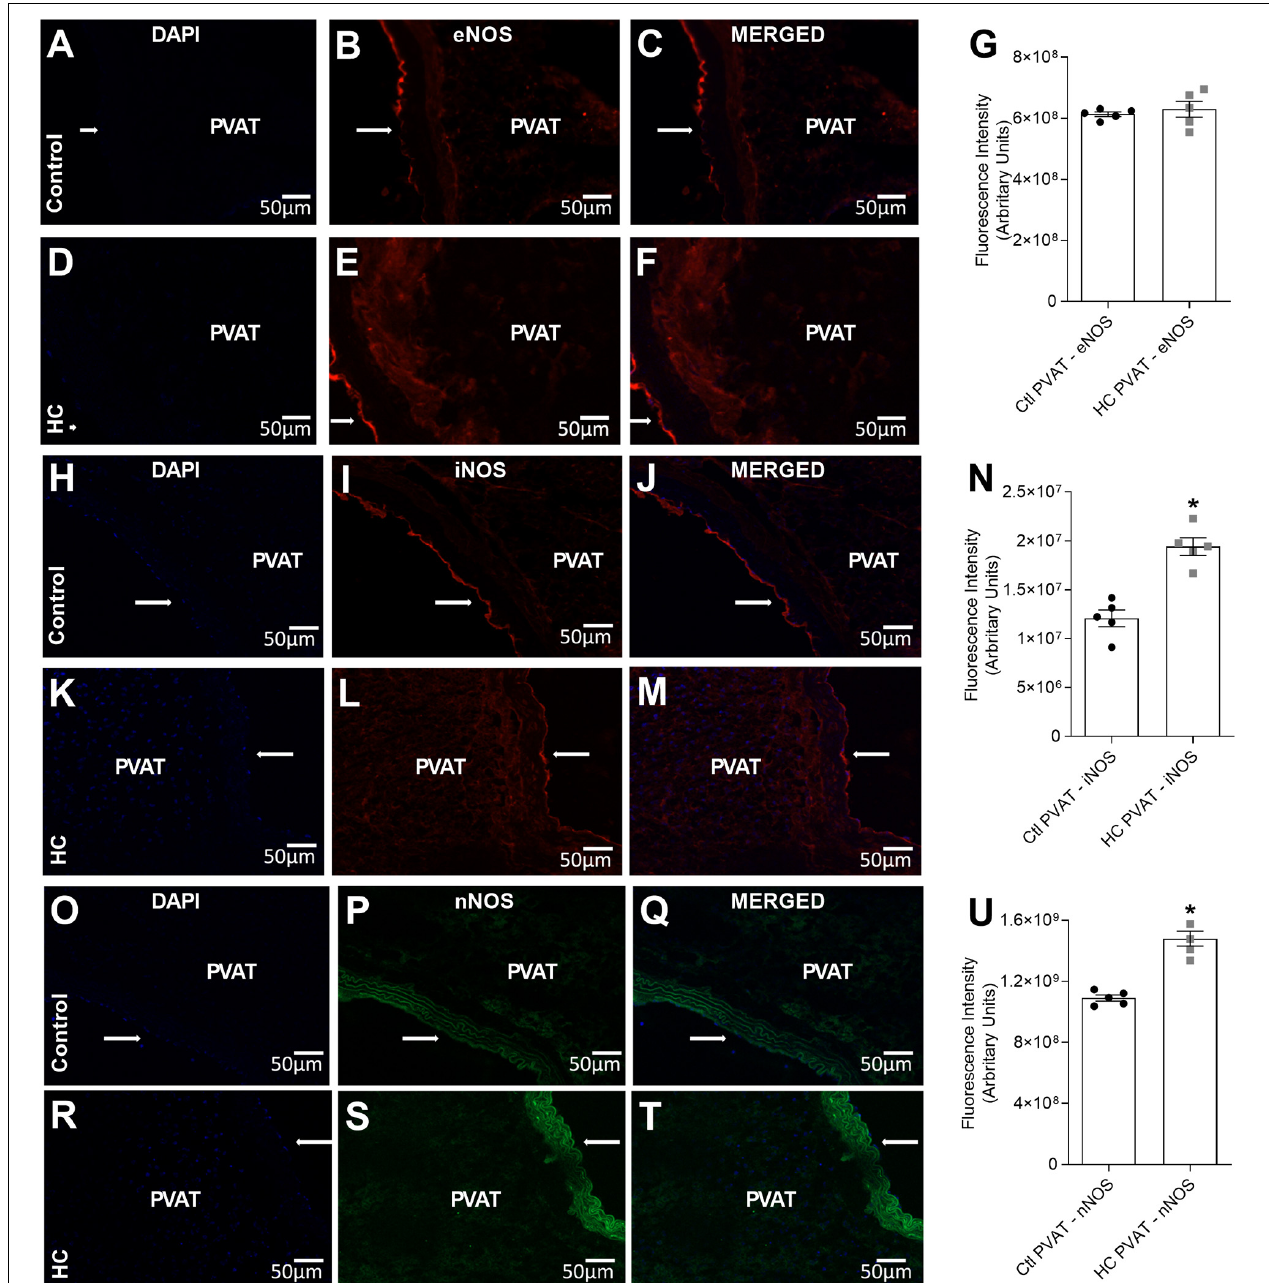
FIGURE 9 | Immunofluorescence of eNOS, iNOS and nNOS in the PVAT of control and HC groups. (A,D,H,K,O,R) Nuclear immunostaining with DAPI. Immunostaining for (B,E) eNOS, (I,L) iNOS or (P,S) nNOS. Overlap of immunostaining for (C,F) eNOS and DAPI, (J,M) iNOS and DAPI or (Q,T) nNOS and DAPI. Fluorescence intensity emitted by binding the selective secondary antibody to (G) eNOS (red fluorescence), (N) iNOS (red fluorescence), or (U) nNOS (green fluorescence) in the PVAT, respectively, were represented in graphical bars with mean ± SEM. The total number of animals required to carry out the experiments in each group ( n ) is presented in the dispersion points in the graphs. Statistical significance was determined using Student’s t -test. * p < 0.05 vs. control. Arrows indicate the location of the endothelial layer of blood vessels. Scale bars indicate 50 µ m.